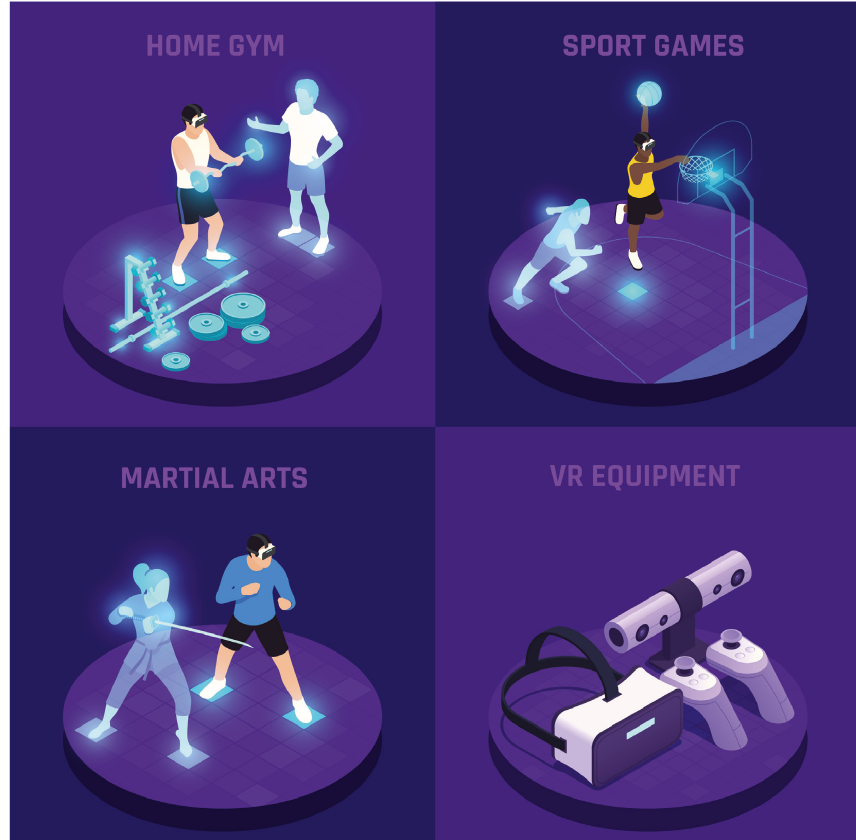
Figure 14: The activities that Metaverse allows in the virtual sphere without having to leave one’s home